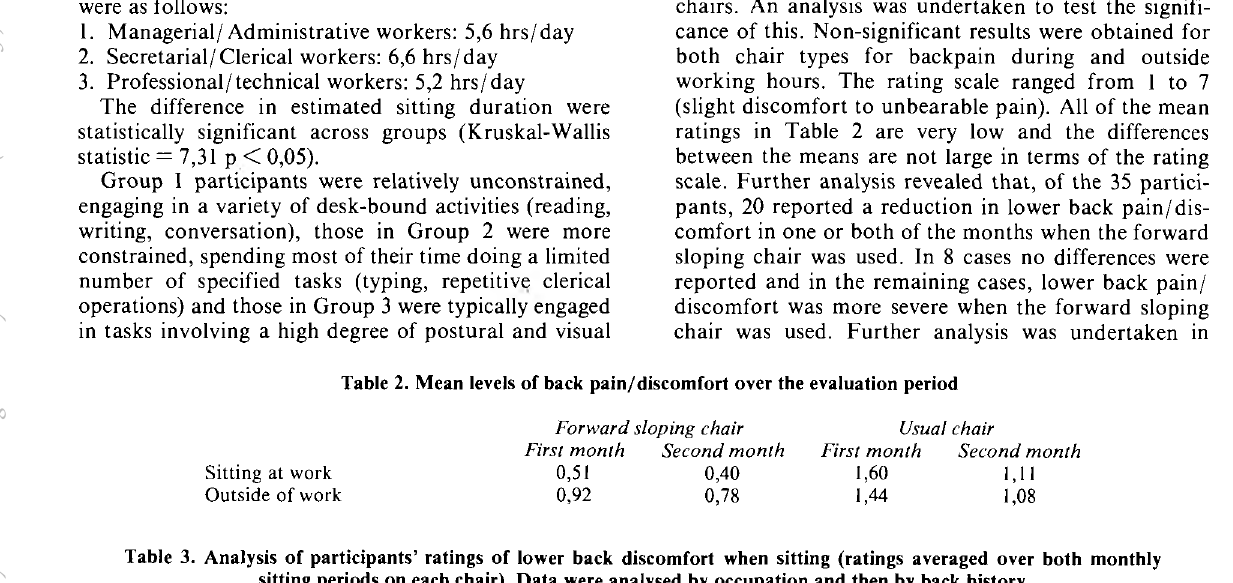
Table 3. Analysis of participants’ ratings of lower back discomfort when sitting (ratings averaged over both monthly sitting periods on each chair). Data were analysed by occupation and then by back history Analysis